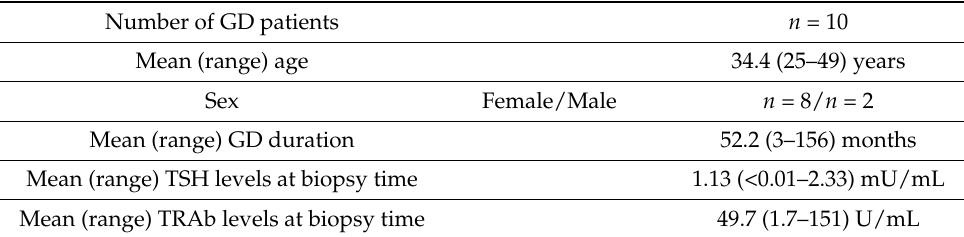
Table 1. Characteristics of patients with GD included in this study.